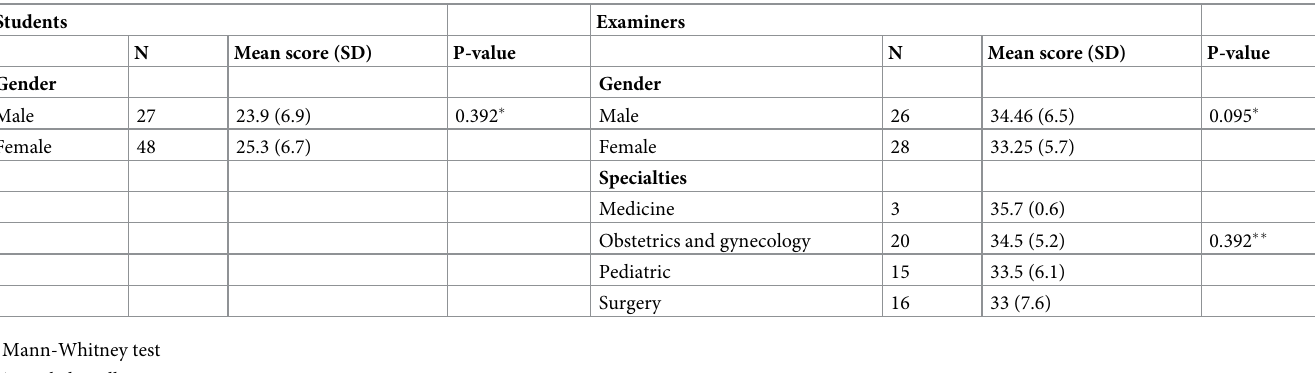
Table 1. Mean satisfaction scores of the online assessment evaluation scales by gender and specialty.